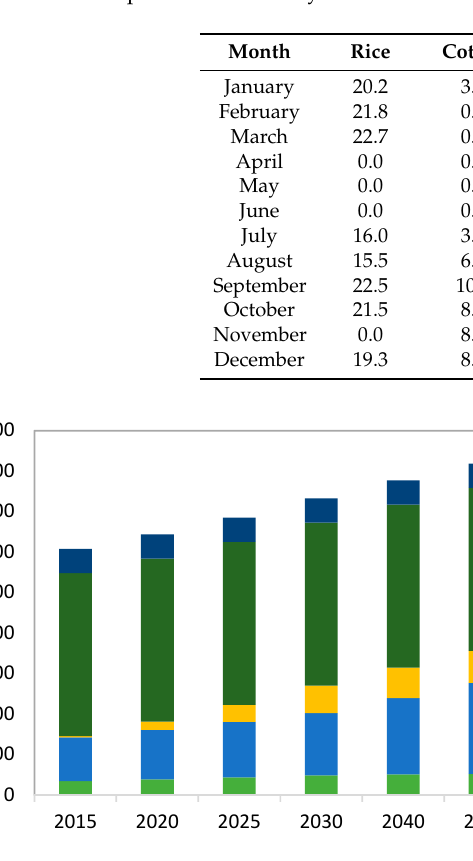
Figure 3. Total annual demand values over selected time periods for the median scenario (50% demand).